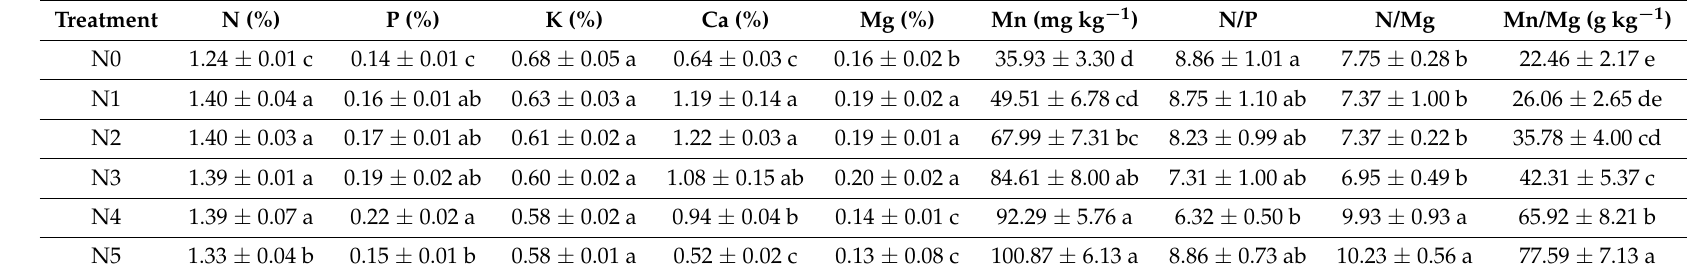
Table 1. Effects of different N supply rates on the mean ( ± SE) values of foliar nutrient status.